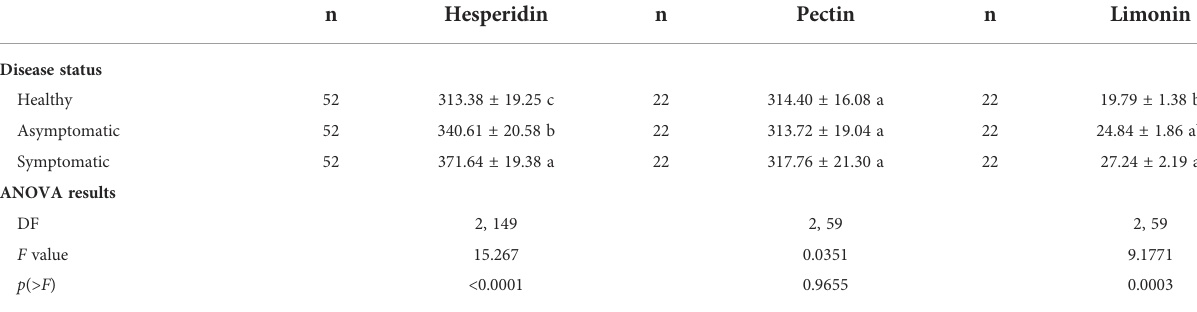
TABLE 6 Content of secondary metabolites of extracted ‘ Femminello ’ lemon juice from fruits collected from healthy trees and from the asymptomatic and symptomatic sector of HLB-affected trees (diseased trees) collected in different harvesting seasons in the south-southeast of São Paulo State yz .